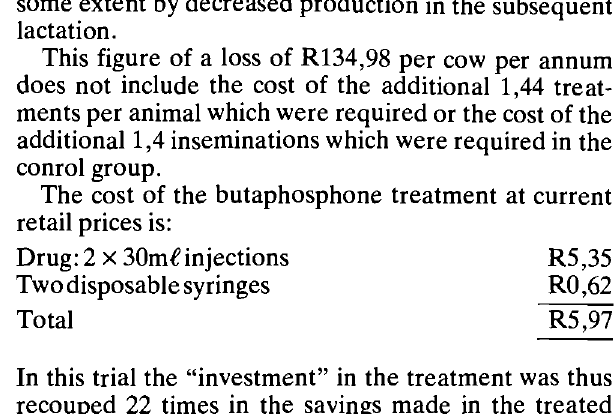
Table 7: CULLING RATE IN THE 14 MONTHS FOLLOWING THE TRIAL